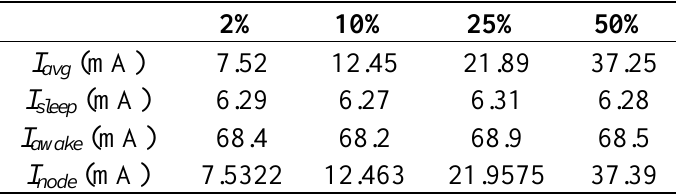
Table 2. Current consumption at sleep and wake-up state for different duty-cycle rates (XBEE radio transceiver).